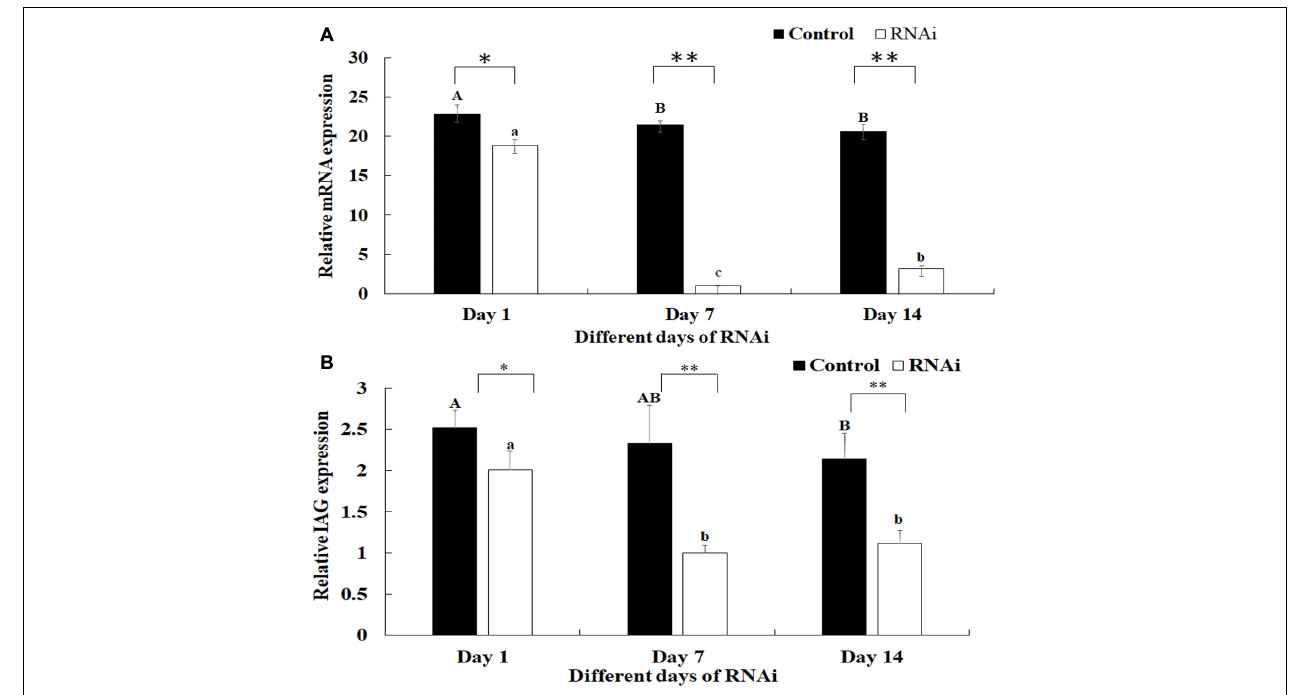
FIGURE 8 | Expression characterization of Mn-SDHB and Mn-IAG at different days after Mn-SDHB dsRNA injection. The amount of Mn-SDHB and Mn-IAG mRNA was normalized to the EIF transcript level. Data are shown as mean + SD (standard deviation) of tissues from three separate individuals. Capital letters indicate expression difference between different days after vehicle injection in control group. Lowercase indicate expression difference between different days after Mn-SDHB dsRNA injection in RNAi group. * ( P < 0.05) and ** ( P < 0.01) indicates significant expression difference between the RNAi group and control group at the sample day. (A) Expression characterization of Mn-SDHB at different days after Mn-SDHB dsRNA injection. (B) Expression characterization of Mn-IAG at different days after Mn-SDHB dsRNA